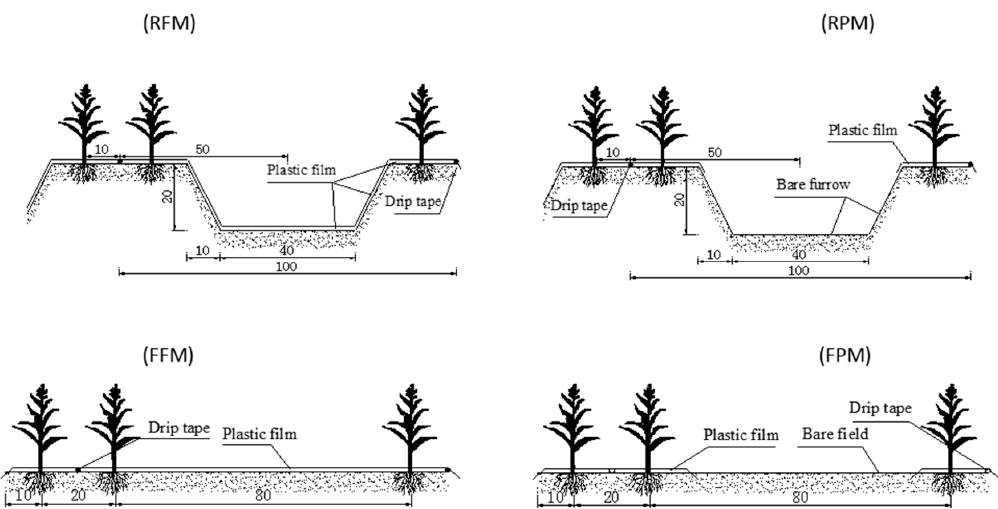
Figure 2. Schematic showing the cropping pattern.